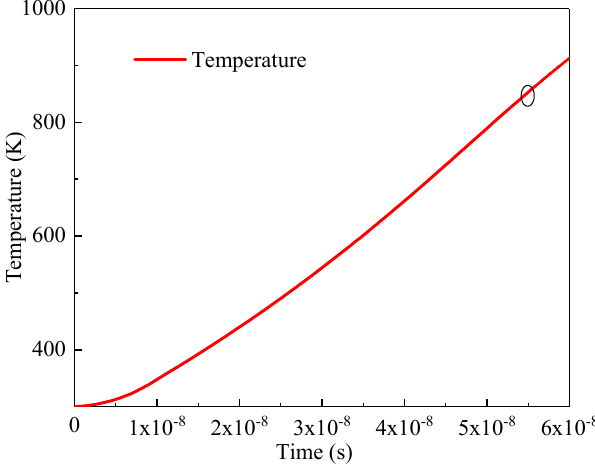
Figure 9. Temperature versus time curve of the Ge-source TFET in the ESD protection network.